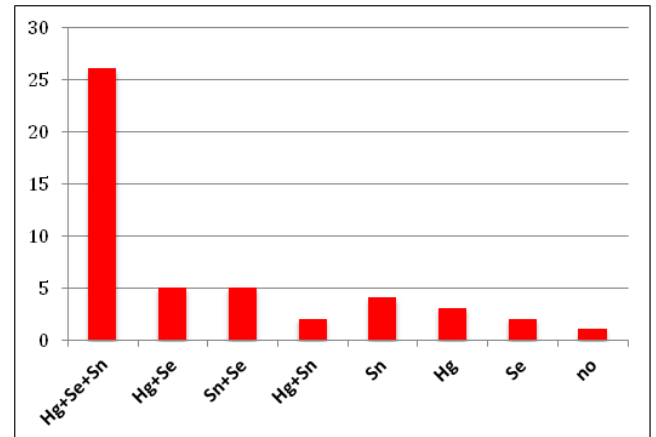
Figure 2. Number of individuals in the cohort of newborns with birth defect with hair load of contaminants higher than the median levels of controls and association of these metals. no = no metal above